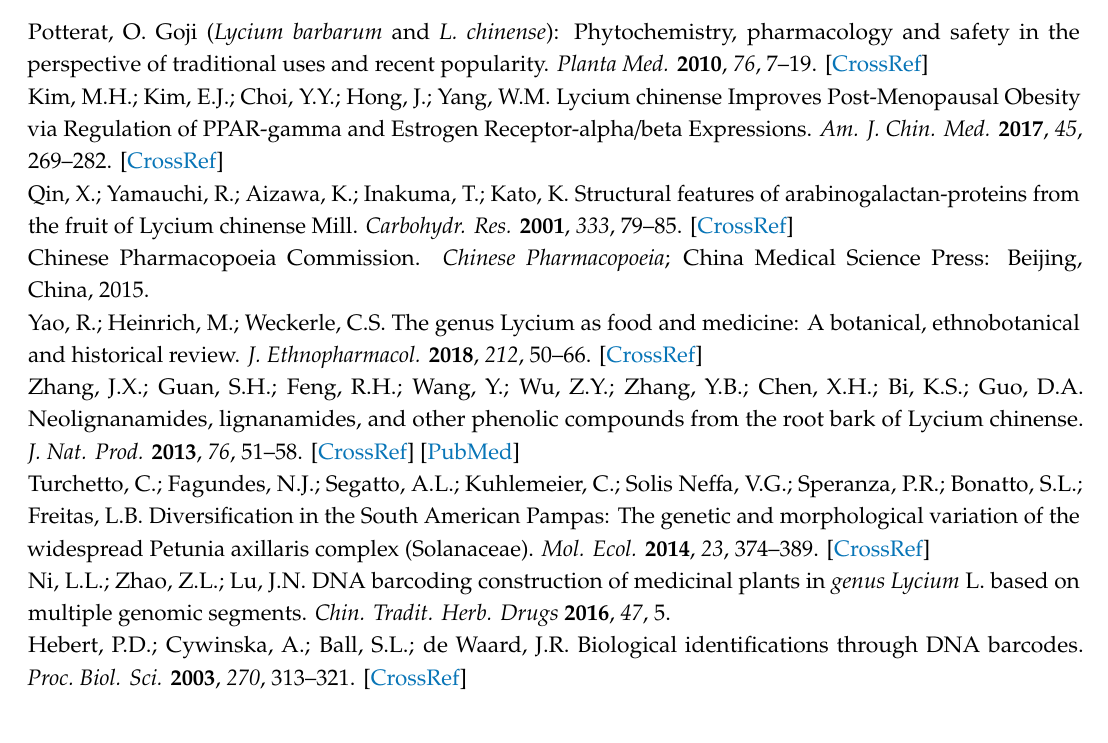
Table S1: Codon usage in the L. chinense chloroplast genome, Table S2: RNA editing predicted in the chloroplast genomes of L. chinense by the PREP, Table S3: Chloroplast genomes used to study their phylogeny relationship in this